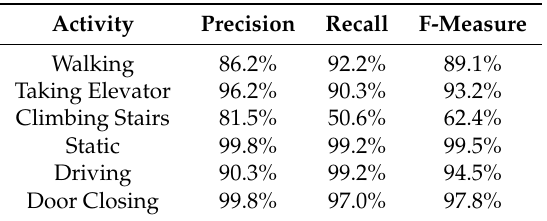
Table 6. The detection performance of the UCD.